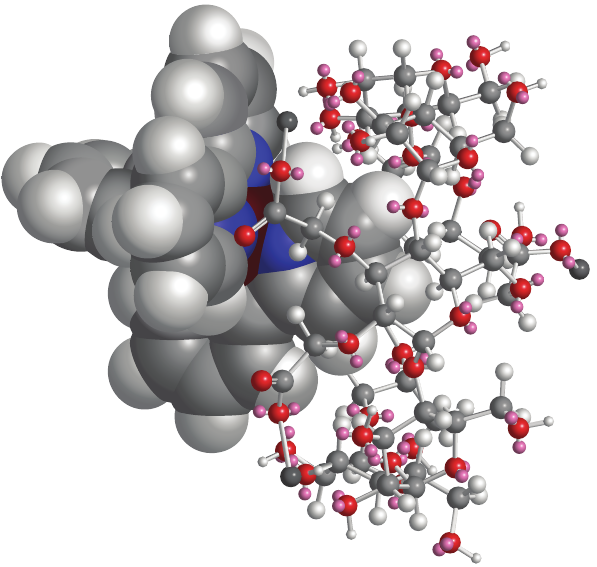
Figure 4: Minimum energy structure of the Ru-dye/CM- 𝛽 -CD complex as calculated by MM2. The Ru-dye/CM- 𝛽 -CD complex was modeled and subjected to geometry optimization to the most energetically stable structure using CS Chem3D.